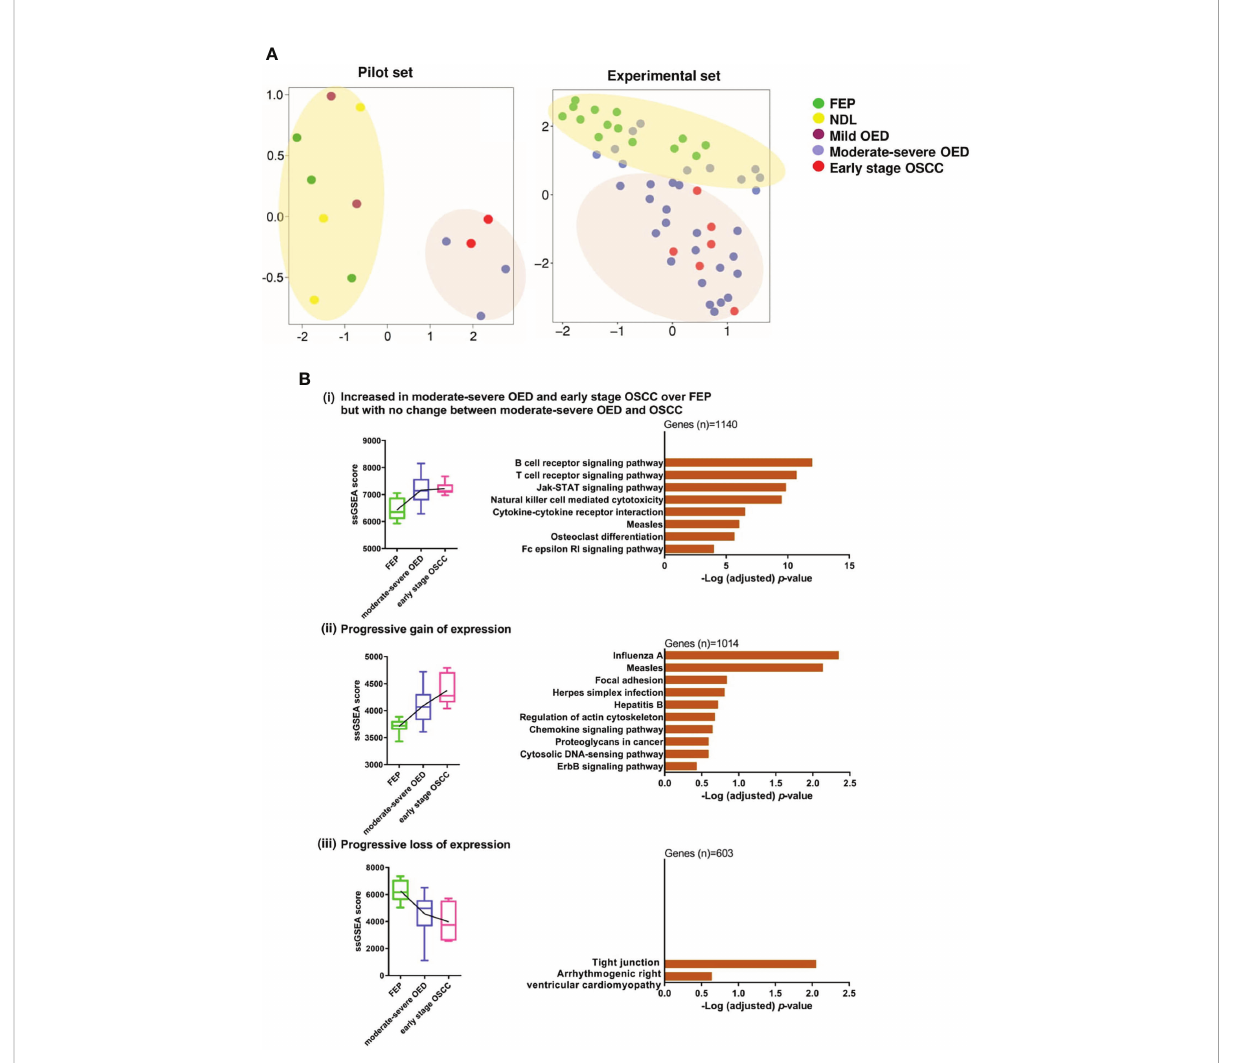
FIGURE 2 Gene co-expression analysis revealed immune-related genes are signi fi cantly overexpressed in moderate-severe OED. (A) Unsupervised clustering of samples based on global gene expression. UMAP plot for the pilot RNA sequencing dataset (n=13) revealed that FEP, NDL and mild OED shared a similar gene expression pro fi le and are distinct from the moderate-severe OEDs which were grouped with early stage OSCC (left). UMAP plot of the experimental dataset (n=51) demonstrating FEP and OSCC samples formed 2 separate clusters (right). Majority of moderate- severe OED samples clustered with OSCC samples (bottom) but others were grouped with FEP samples (top). (B) Identi fi cation of gene co- expression trends across FEP, OED and OSCC. Pathways representing the co-expressed gene modules were shown as bar plots. (i) Increased in moderate-severe OED and early stage OSCC over FEP but with no change between moderate-severe OED and OSCC: Immune-related pathways were upregulated in moderate-severe OED and sustained at a similar level in early stage OSCC. (ii) Progressive gain of expression: A mixture of genes involved in cancer-related and immune-related pathways continuously upregulate from FEP to moderate-severe OED and further into early stage OSCC. (iii) Progressive loss of expression: Genes involved in tight junction pathway are continuously downregulated from FEP to moderate-severe OED and further in early stage